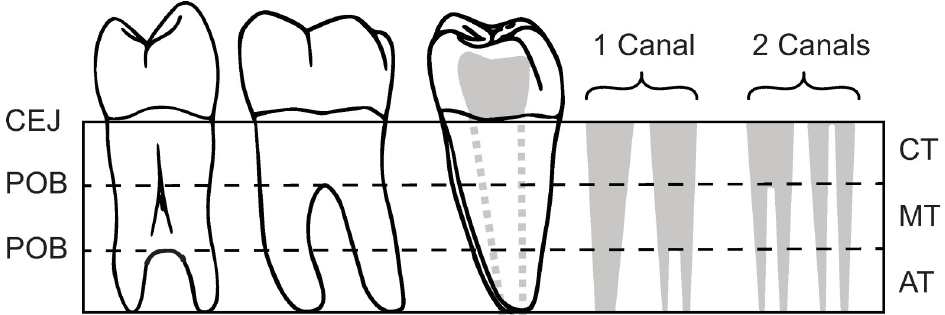
Fig 8. Determination of root and canal number. Left = Distal view of single-rooted premolar with bifurcation of the apical third of the root. Middle: Lingual view of double-rooted mandibular molar. Right: Distal root of double-rooted mandibular molar with examples of canal counts in solid gray. Dotted gray lines indicate canal/s position in root. CEJ = Cemento-enamel junction, POB = Point of bifurcation, Solid gray = canals. CT = cervical third, MT = middle third, AT = apical third.